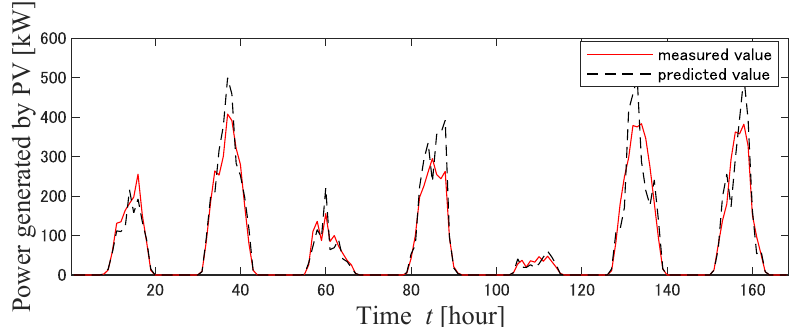
Figure 5. Generated power of PV